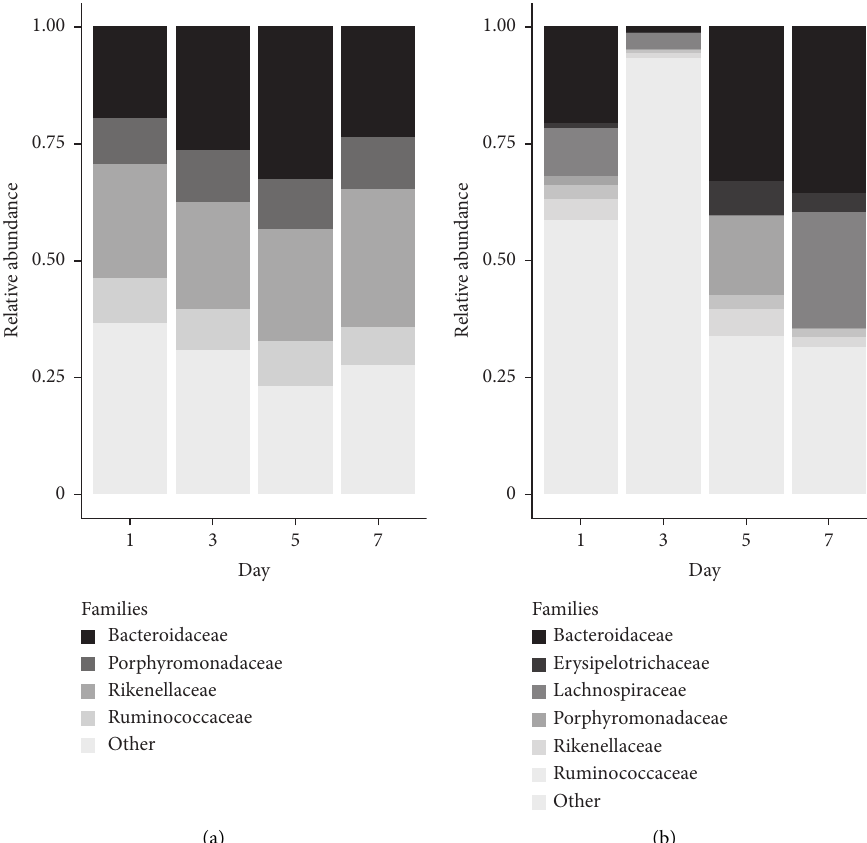
Figure 1: Relative abundances of microbial families in samples of a healthy male and a female IBS patient. In this figure, the fecal samples collected on alternate days during the follow-up period have been considered. (a) Healthy male. (b) Female IBS